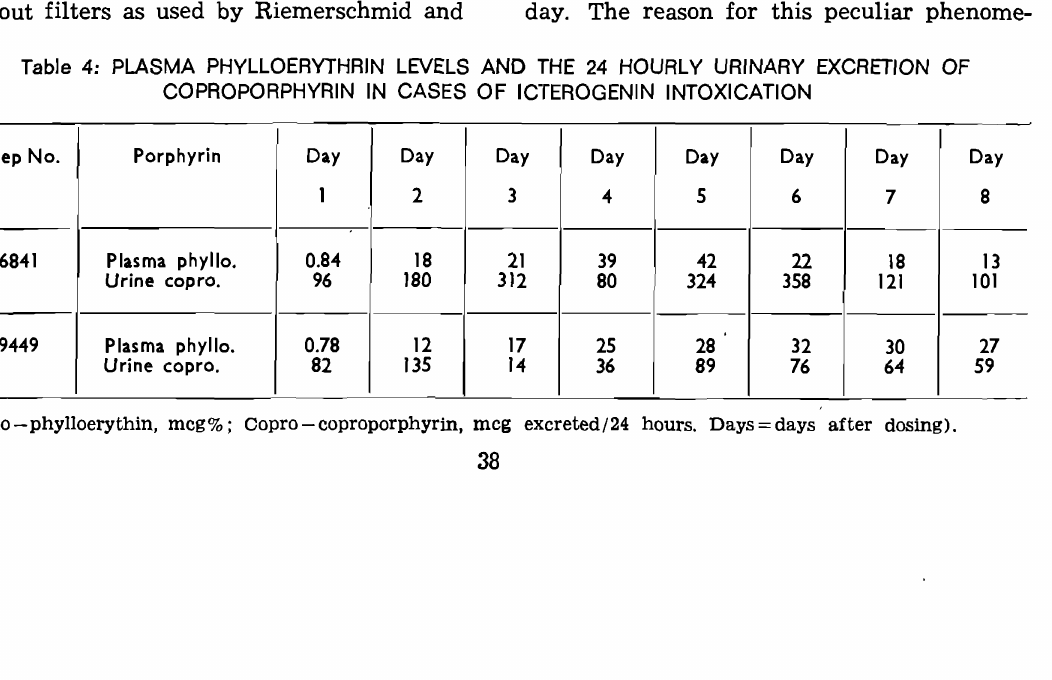
Table 4: PLASMA PHYLLOERYTHRIN LEVELS AND THE 24 HOURLY URINARY EXCRETION OF COPROPORPHYRIN IN CASES OF ICTEROGENIN INTOXICATION Sheep No.